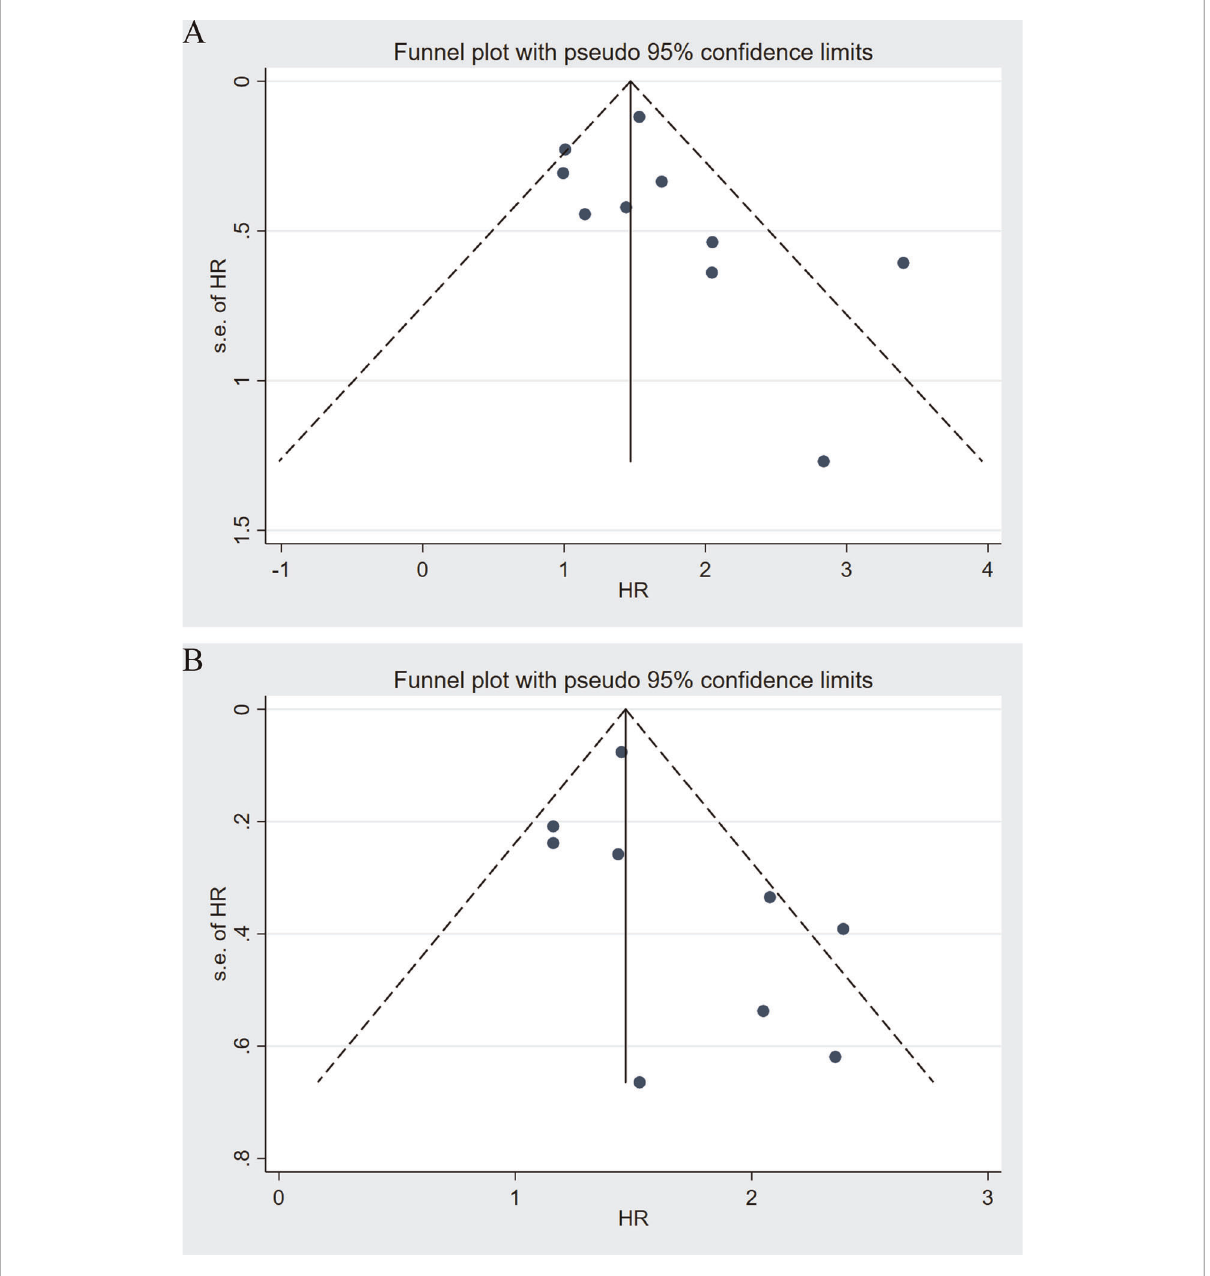
FIGURE 6 Funnel plot of the association between lymph node ratio with overall survival (A), disease-free survival